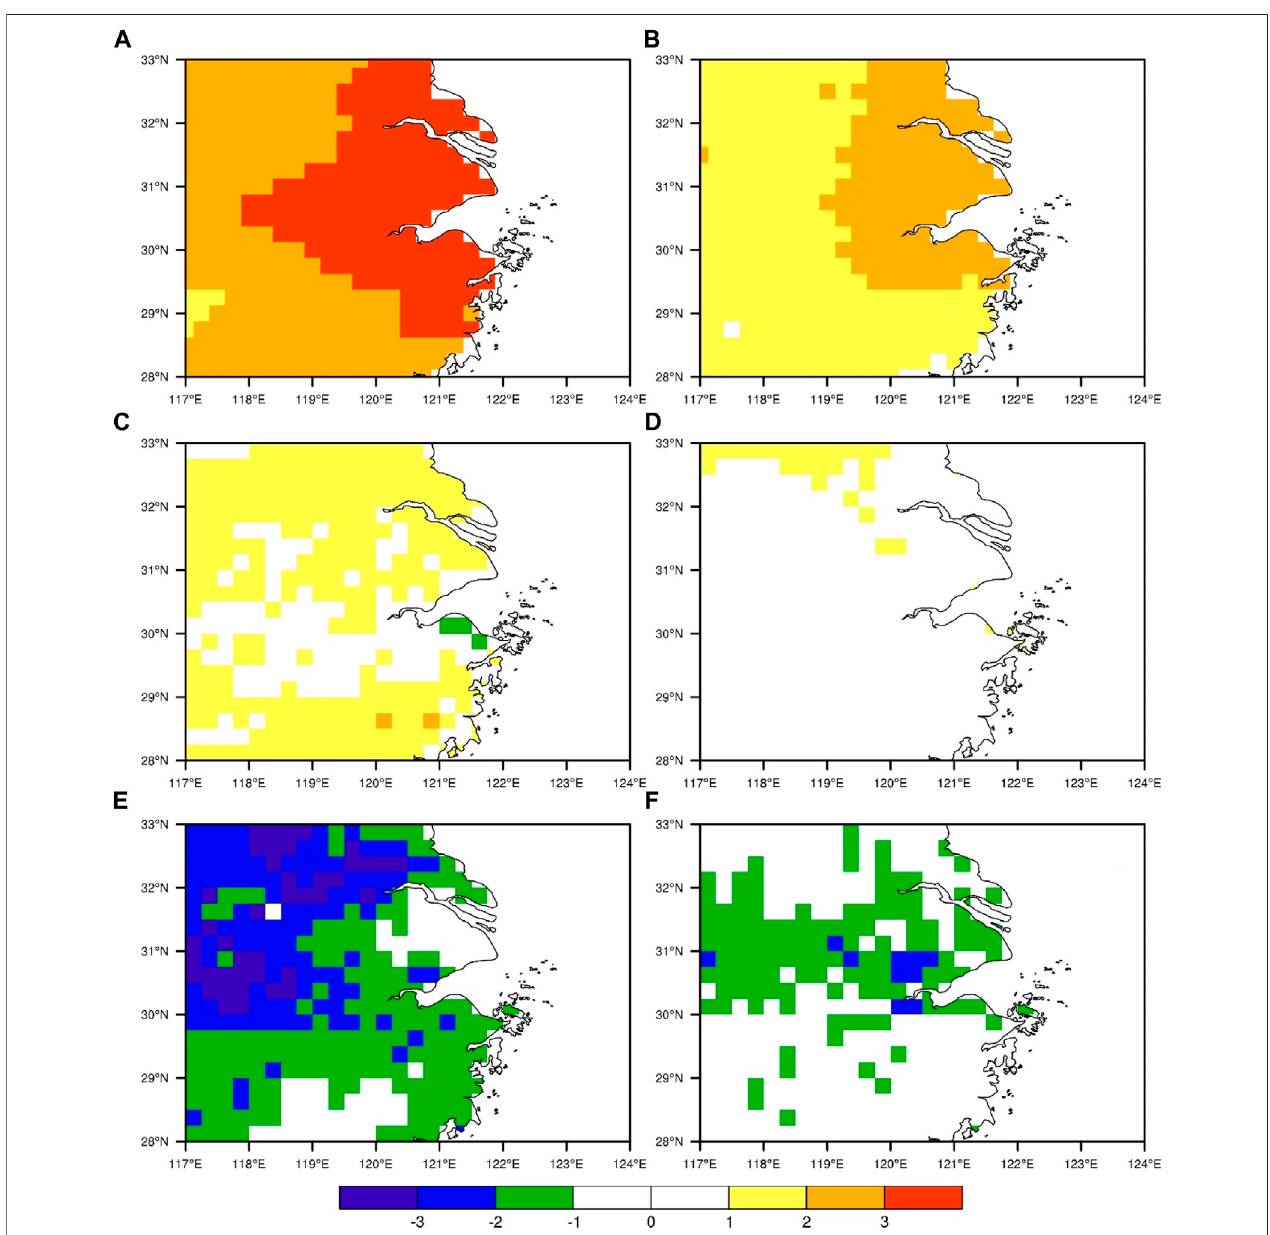
FIGURE 10 | Spatial patterns of standardized anomalies of air temperature for (A) 2013 and (B) 2017. The standardized anomaly is shown as a reference period (i.e., August 7 – 9, 2013 or July 21 – 23, 2017) calculated from its long term mean and standard deviation from 2003 to 2018, excluding 2013 and 2017. (C,D) Same as (A,B) , but for ET. (E,F) Same as (A,B) , but for surface soil